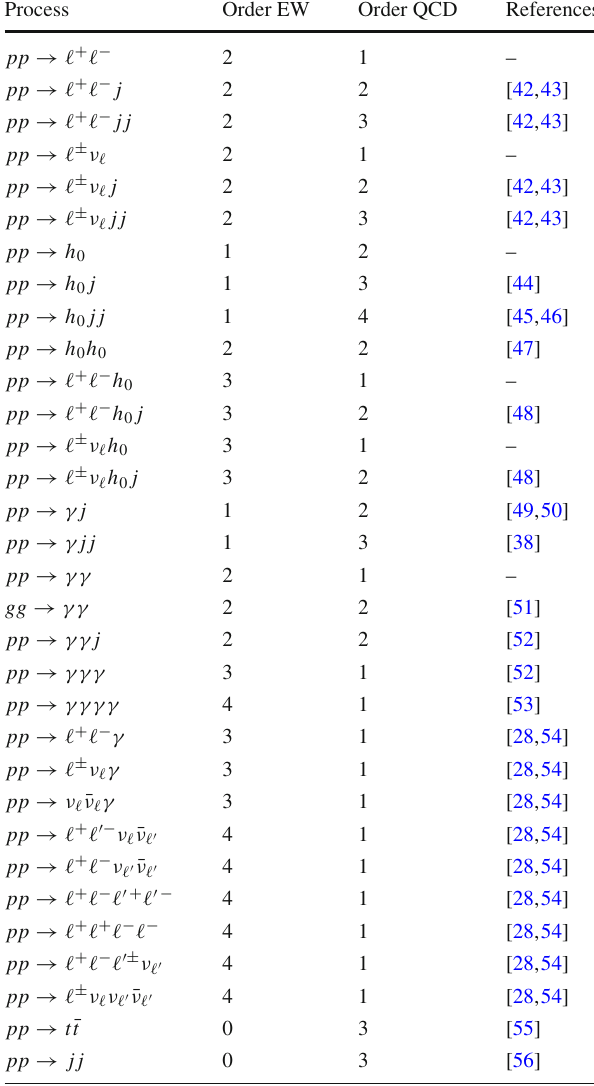
Table 1 Processes available in the Standard Model